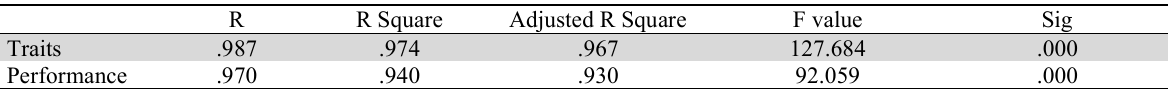
ANOVA statistics R R Square Adjusted R Square Traits .987 .000 Performance .970 .940